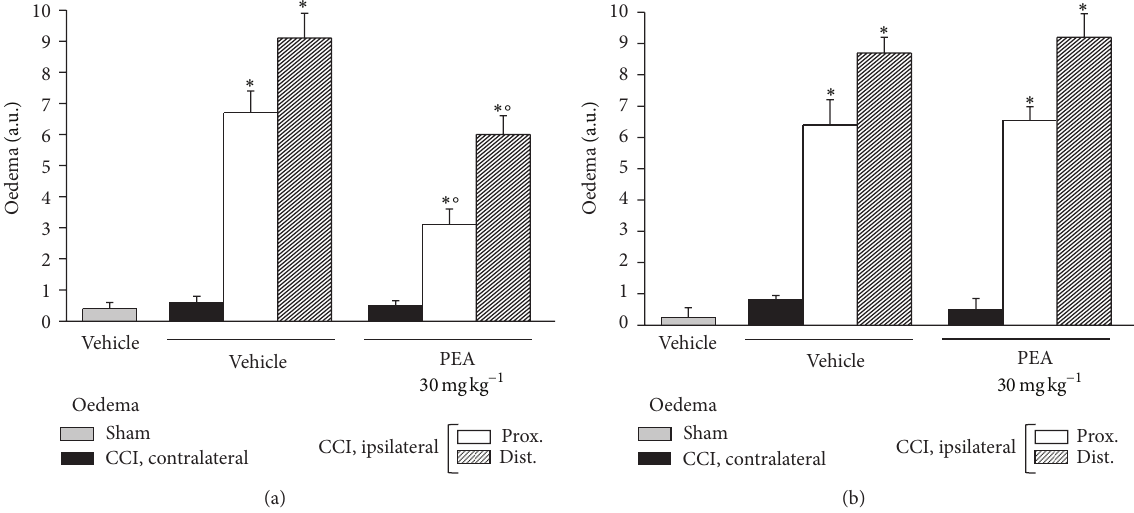
Figure 6: Oedema evaluation. On the 14th day after CCI, 5 𝜇 m nerve sections of formalin-fixed tissues were analyzed by Azan-Mallory stain and the presence of oedema infiltrate was evaluated and quantified by an arbitrary scale starting from 1, mild oedema, up to 10, widespread oedema. Effect of PEA repeated treatments (30 mgkg −1 s.c. daily) was observed in (a) PPAR- 𝛼 +/+ and in (b) −/− mice where the distal and proximal tract of the ipsilateral ligated nerve of CCI was compared with the contralateral and with the sciatic nerve of sham-operated animals. Quantitative analysis was performed evaluating 5 animals for each group. ∗ 𝑃 < 0.05 was considered as significantly different from sham, vehicle-treated mice. ∘ 𝑃 < 0.05 was considered as significantly different from CCI, vehicle-treated